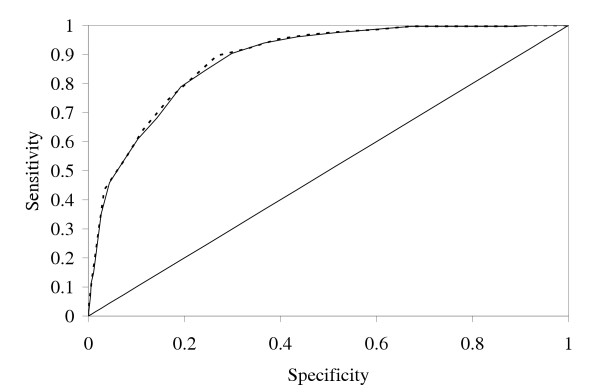
Combined ROC curves with 20% residual activity thresholds. The dotted line shows the curve for the neural network classifier, while the solid line shows the curve for the linear regression classifier.